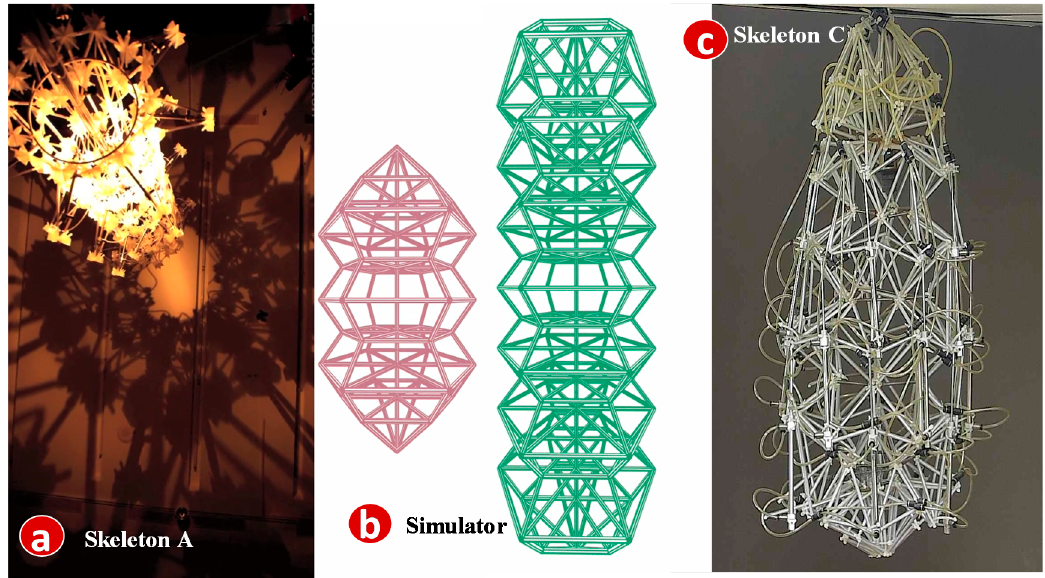
Figure 9. Skeleton: ( a ) geometric-shape shadow of skeleton; ( b ) shape change of the skeleton simulator; ( c ) another implementation of real skeleton device.